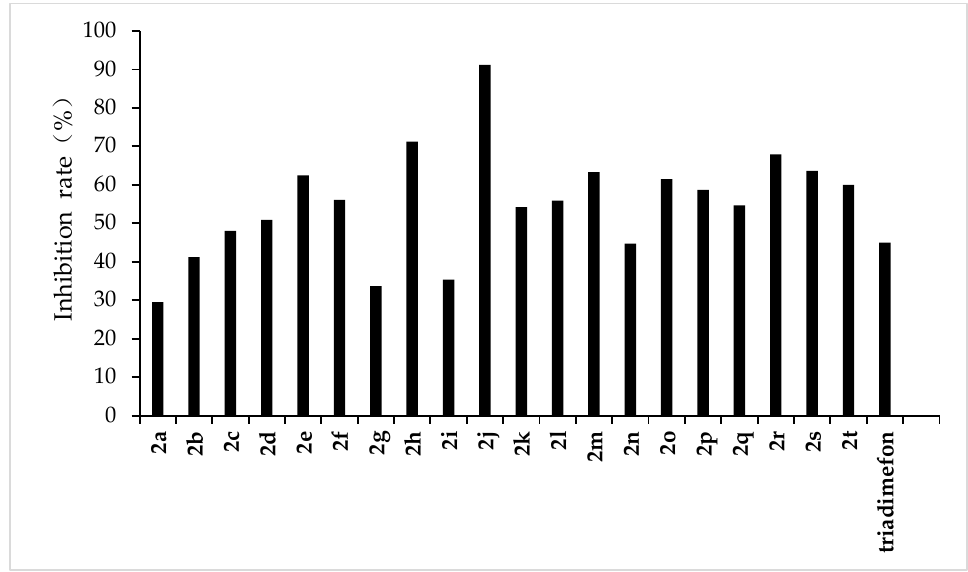
Figure 5. Antifungal activity of the synthesized compounds ( 2a ‒ 2t ) against F. moniliforme.